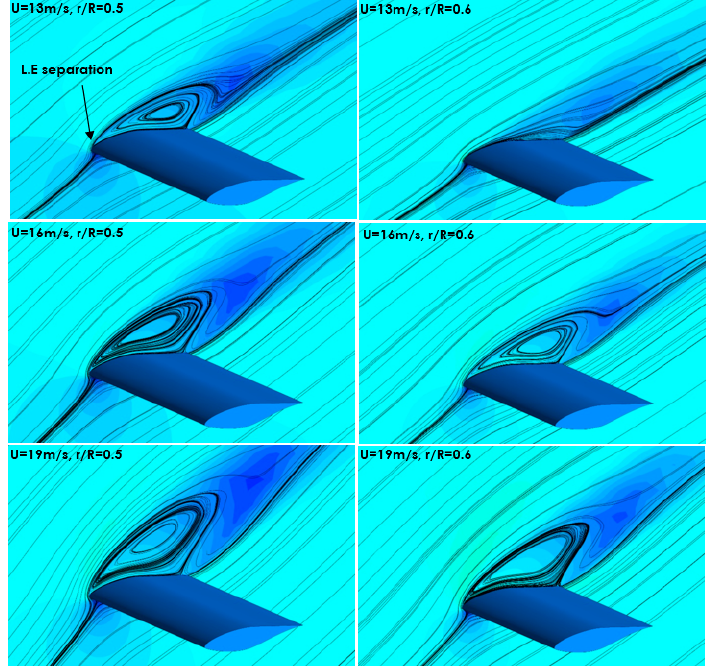
Figure 10. Streamlines and velocity distributions for baseline configuration at r/R = 0.5 and r/R = 0.6 for windspeeds U ∞ = 13 m s − 1 , 16 m s − 1 , and 19 m s − 1 .